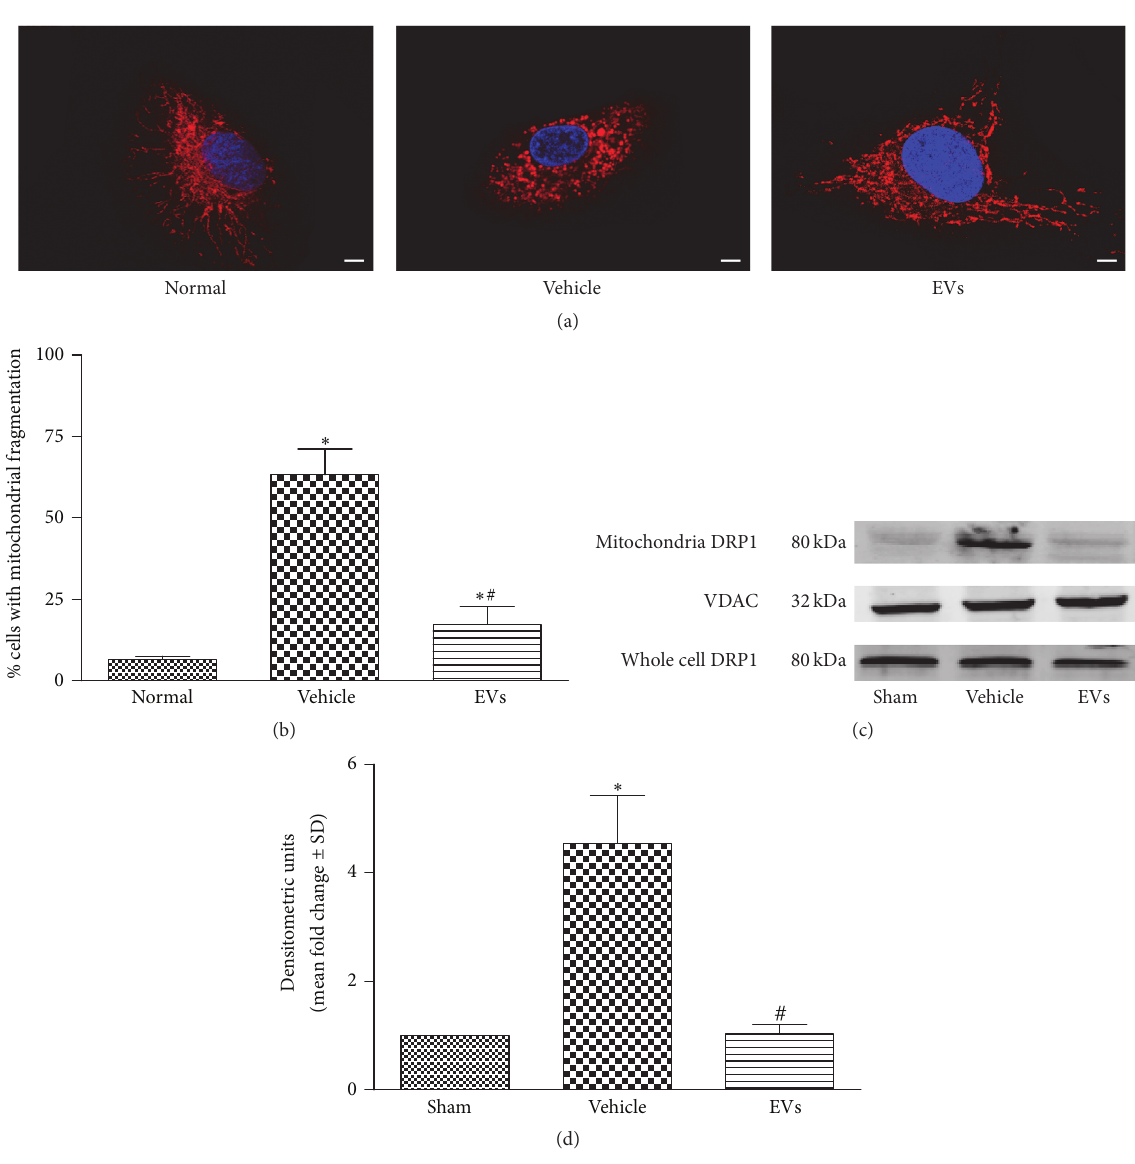
Figure 1: hWJMSC-EVs alleviate mitochondrial fragmentation and DRP1 activation in the model of IRI in vitro and in vivo. (a) Two hours after the treatment with azide, the renal tubular epithelial cells were stained with MitoTracker Red. The morphological alterations of mitochondria in renal tubular epithelial cells were imaged using a laser scanning confocal microscope (theoriginal magnification is 630x). Bar = 5 um. (b) The percentage of cells undergoing mitochondrial fission. (c, d) Mitochondrial DRP1 expression in kidney tissues was measured by western blot analysis at 24 hours after sham, IRI, or EVs treatment. VDAC antibody served as a loading control. Data in (b) and (d) are presented as mean ± SD; 𝑛 = 6 ; ∗ 𝑃 < 0.05 , versus sham; # 𝑃 < 0.05 , versus